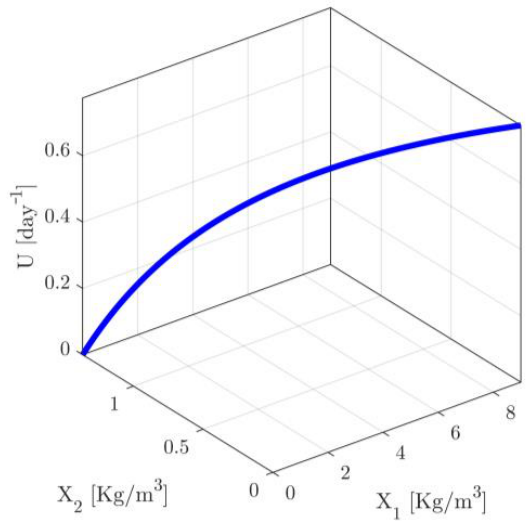
Figure 1. Operating Trajectory of the Chemostat. Applying series of computations, the accuracy areas for all ten scenarios, namely the areas satisfying simultaneously the conditions (18)–(20), are presented in Figure 2, as ten three dimensional volumes with different colors. It can readily be observed that for each operating point there exists a wide range of inputs and initial condition satisfying the accuracy conditions (18)–(20). Furthermore, it is observed there is overlapping between adjacent volumes. In the overlapping, the accuracy conditions are simultaneously satisfied for the adjacent operating points.